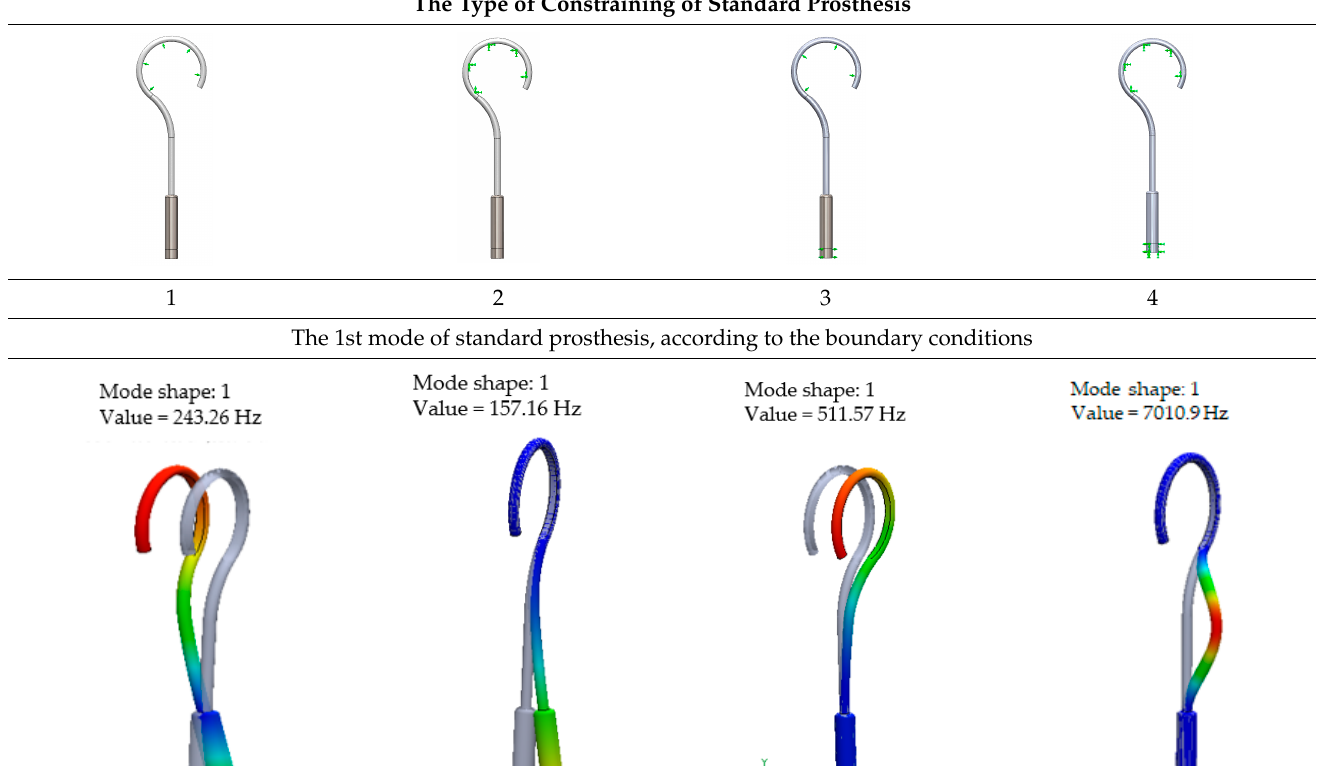
Table 2. The results of eigenfrequency analysis of standard prosthesis: the 1st mode and the eigenfrequencies (Hz) of first 4 modes.